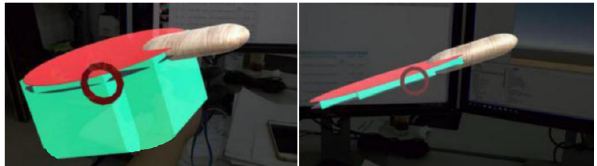
Figure 7. ( left ) Fast move thickness; ( right ) Slow move thickness.